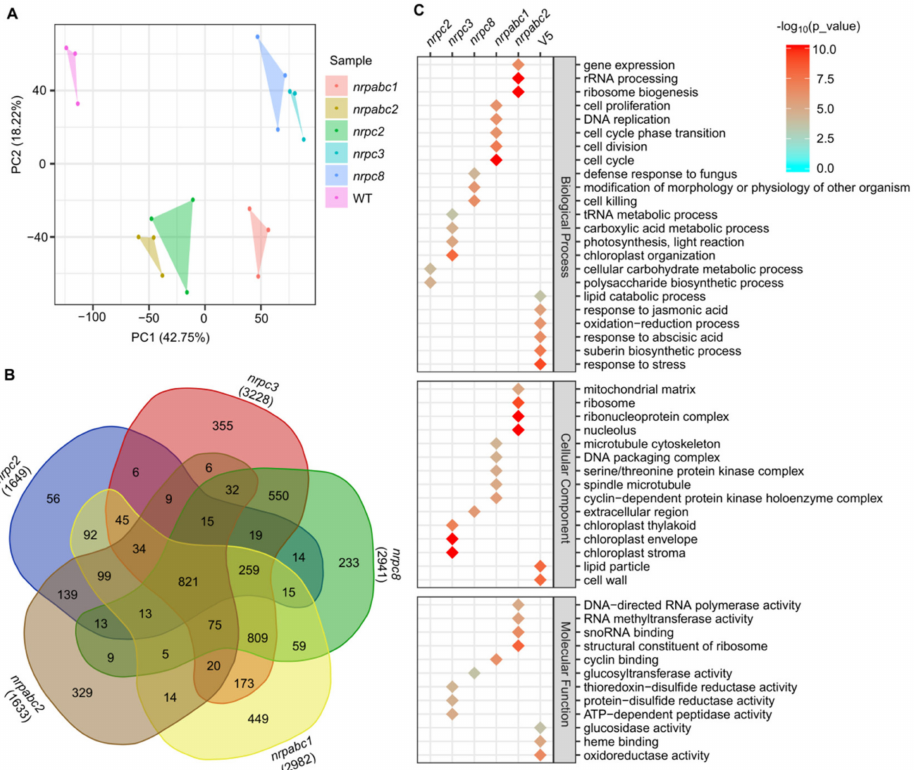
Figure 4. Global transcriptome analysis based on RNA-seq data in 10 DAF seeds of wild-type and different subunit knockdown lines. ( A ) PCA comparing the expressed genes of different samples. ( B ) Numbers of DEGs in the seeds of different subunit knockdown lines compared with the wild-type. ( C ) GO classification for genes with differential expression in the seeds of different subunit knockdown lines compared with the